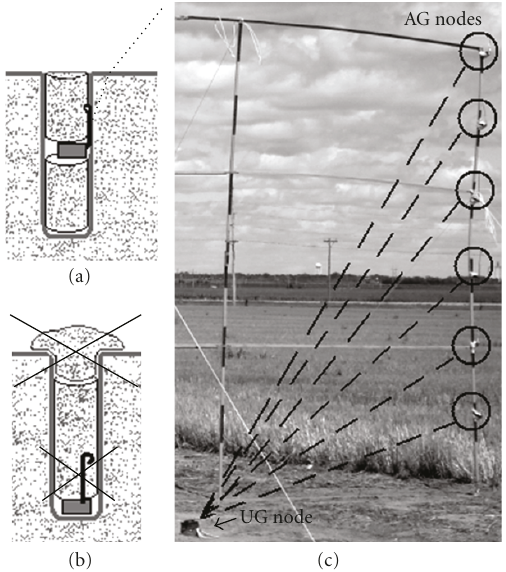
Figure 4: UG2AG and AG2UG experiments. (a) The antenna must be positioned in the direction of the aboveground device and without any obstacle. (b) Some aspects allowed for UG2UG experiments are not allowed for aboveground experiments. (c) Grid of aboveground